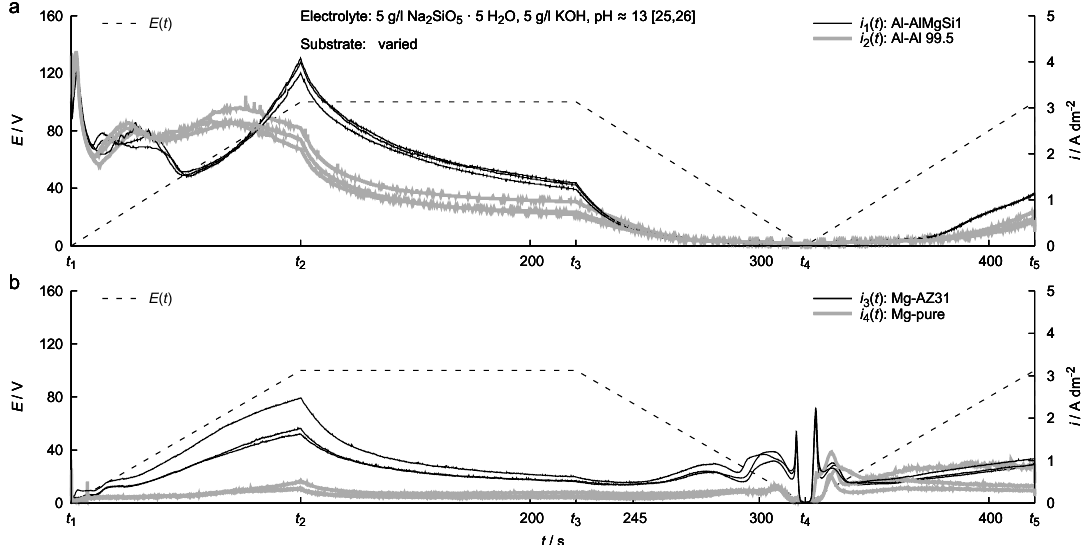
Figure 4. Results of polarisation experiments within an electrolyte which allows for the formation of dense and protective PEO layers on AlMgSi1 [25,26] on various Al ( a ) and Mg ( b ) materials the curves for three repetitions of each measurement are